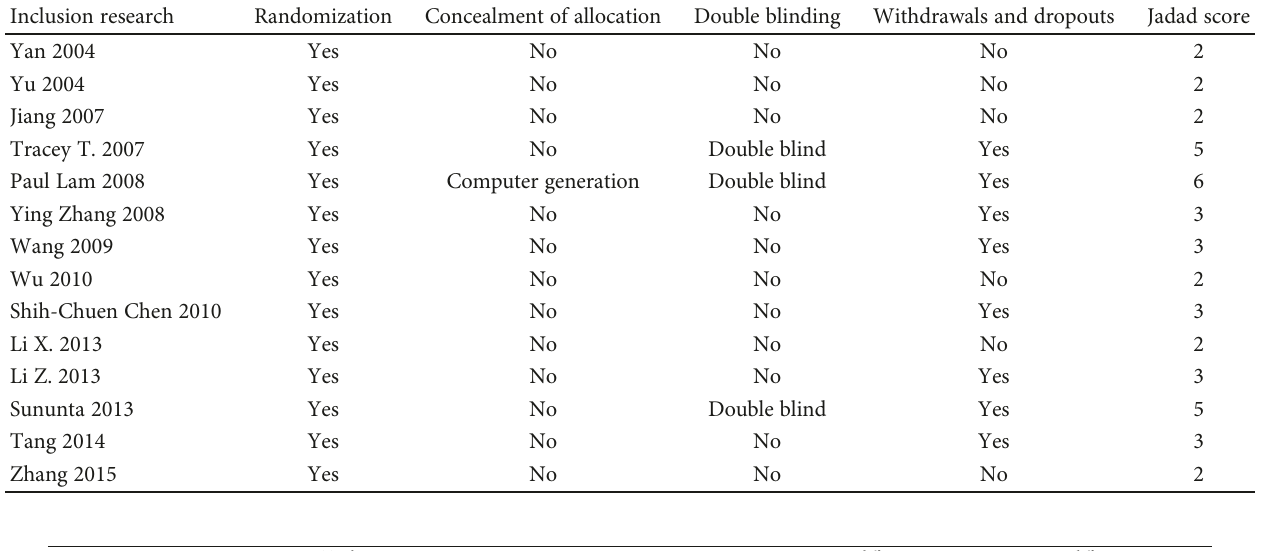
Table 2: The quality evaluation of the methodology.